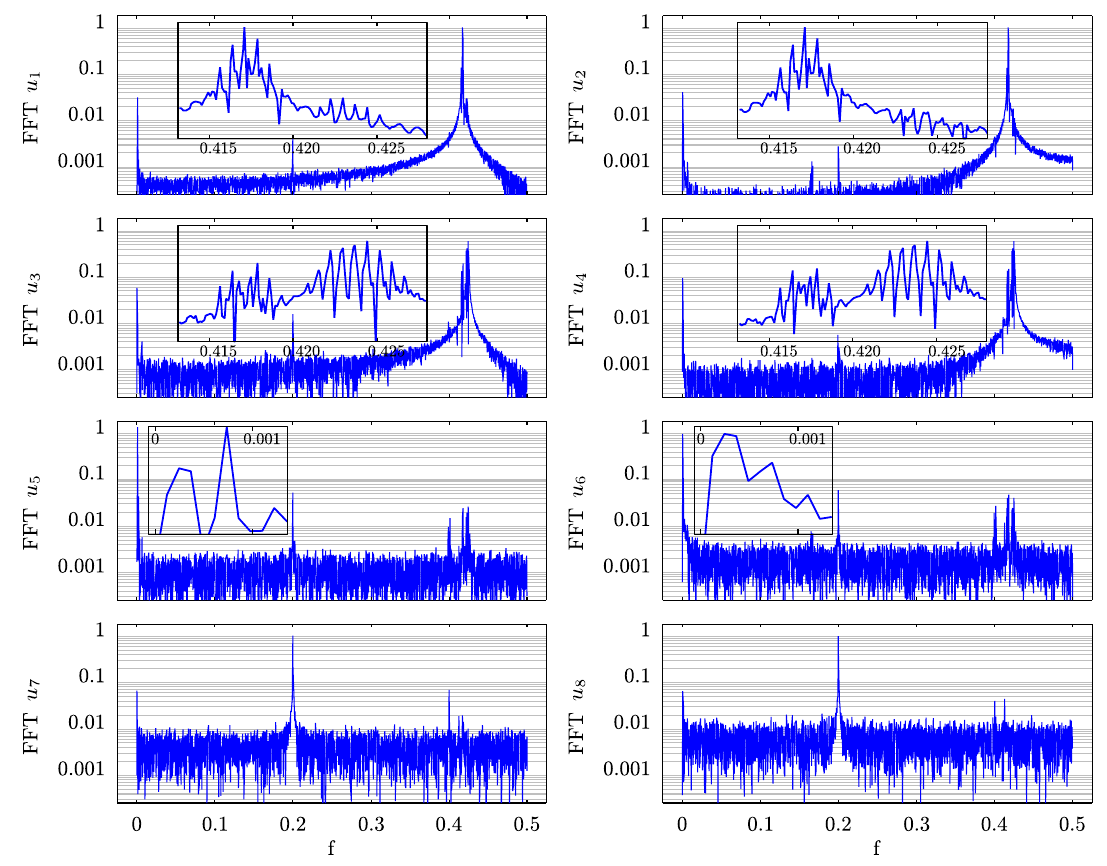
FIG. 4. FFT amplitude spectra of temporal modes presented in Fig.